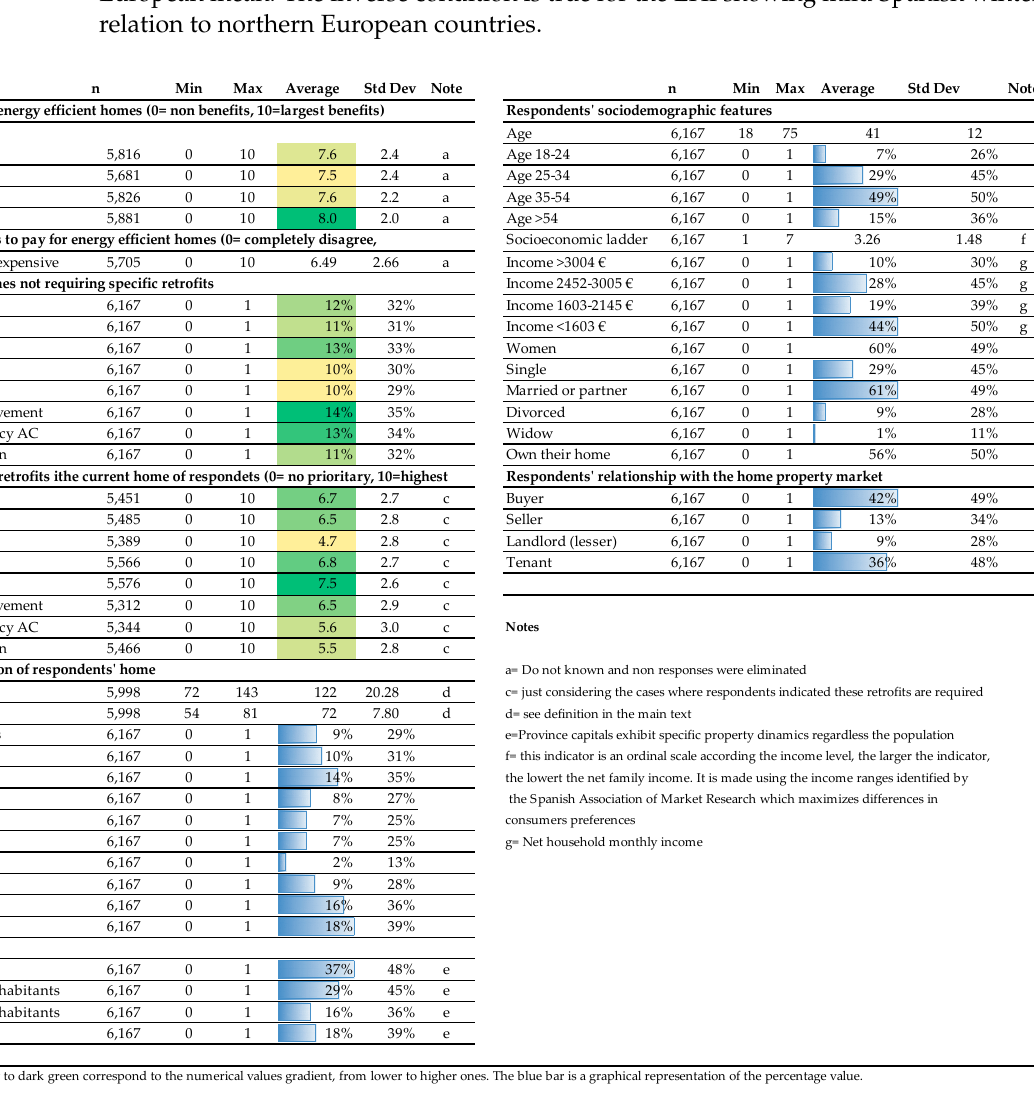
Figure 3. Descriptive statistics. Source: Self elaboration. On a 1 to 10 scale, respondents’ perception on co-benefits associated to energy-efficient homes averages 7.69, being the preservation of interior temperature the most relevant. Only 12% of respondents said their current home does not require any of the